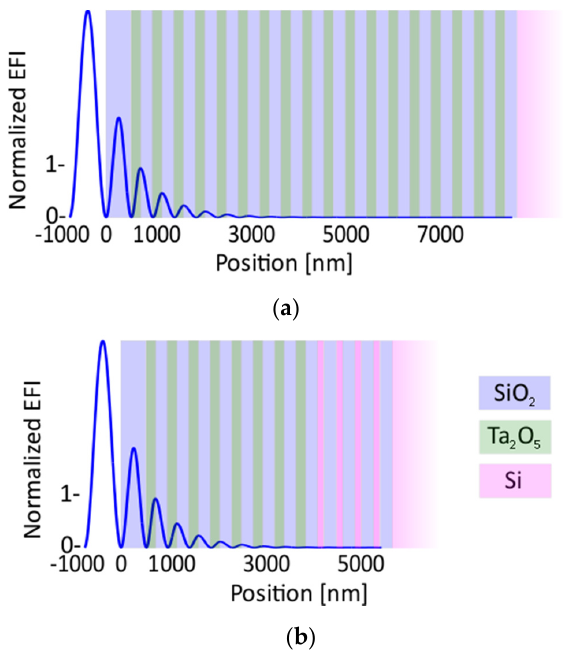
Figure 4. Illustration of electric field intensity within a standard silica/tantala stack ( a ) and a mixed material stack ( b ). In the mixed material model, bilayers of SiO 2 and Ta 2 O 5 are used initially to reduce the laser power, followed by lower layers of amorphous silicon, which can be used to improve thermal noise due to a higher refractive index (reducing thickness and the number of layers) and low mechanical loss.